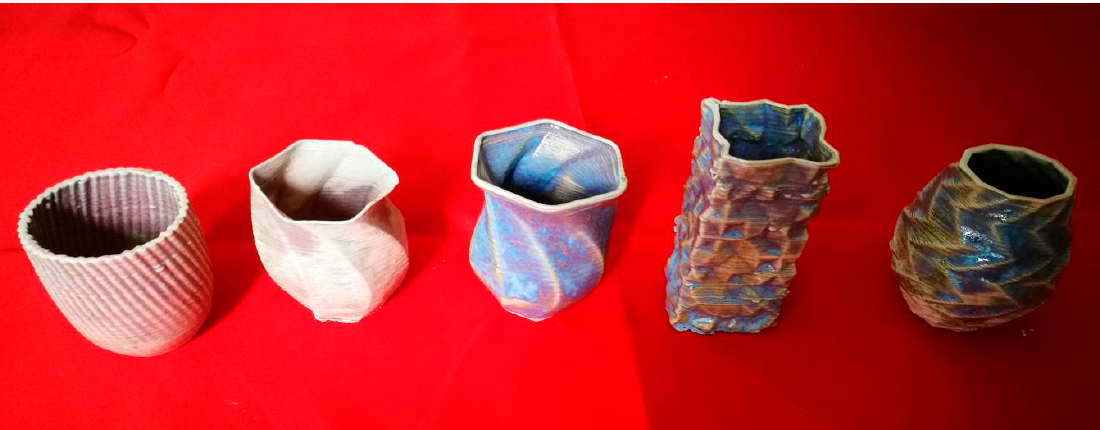
Figure 15. Sintered three-dimensional printed ceramic samples.